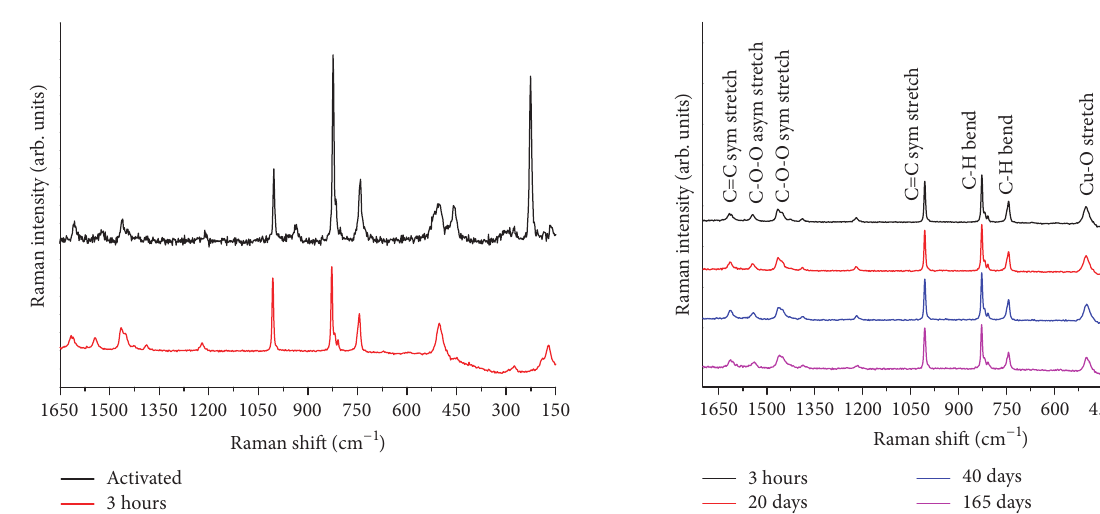
Figure 3: High resolution Raman spectra of HKUST-1 acquired after about 3 hours and 20, 40, and 165 days of exposure to air at 𝑇 = 300 K. Spectra are vertically shifted, for viewing purposes, after the normalization described in the